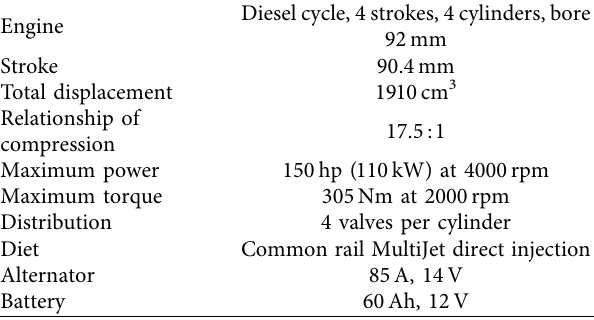
Table 1: Engine specification.